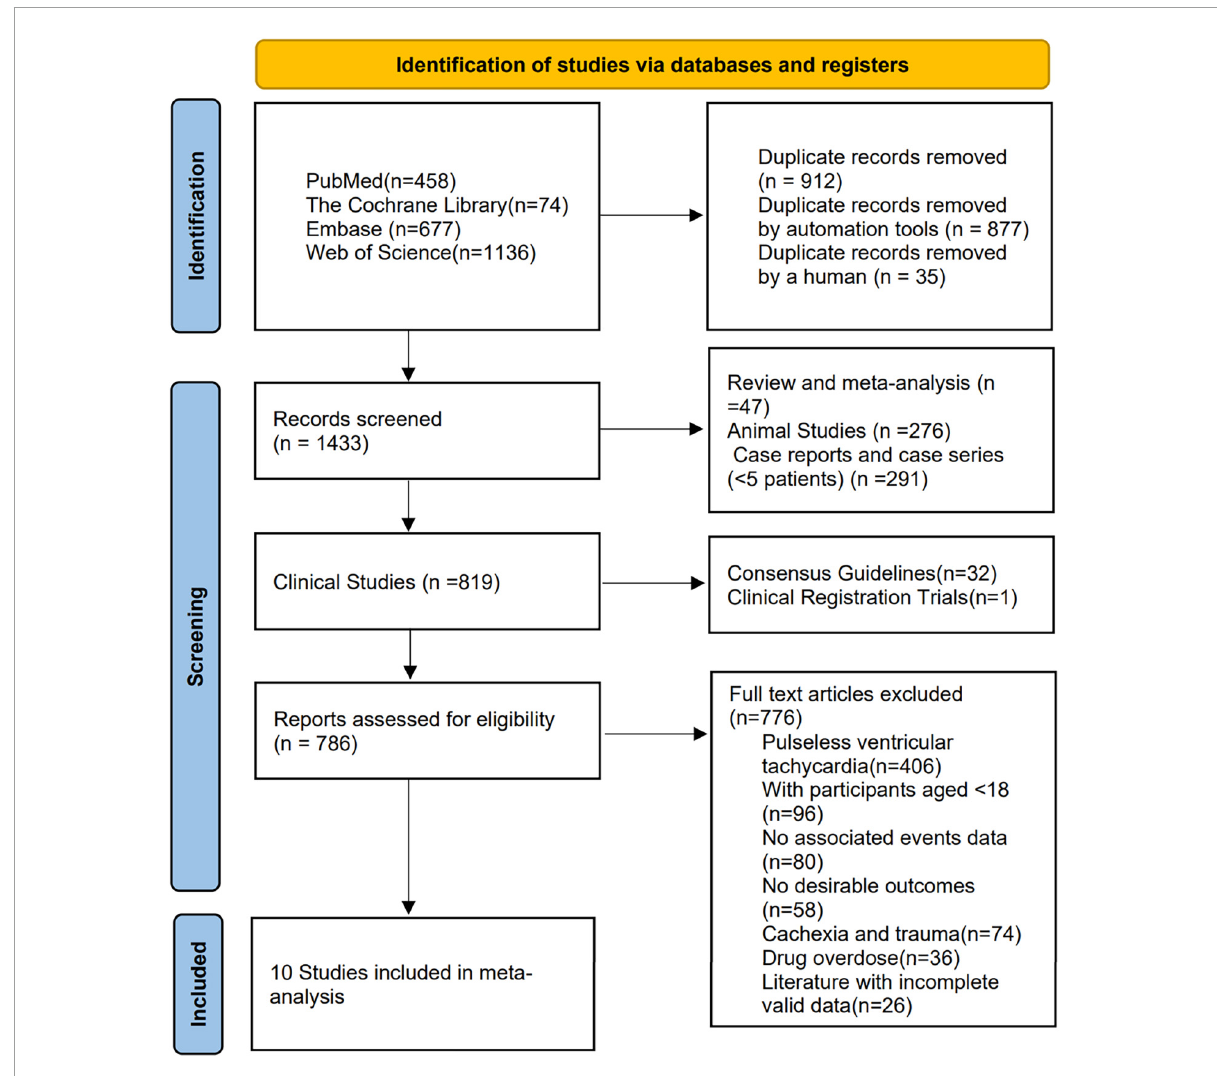
FIGURE1 Flowchart of included